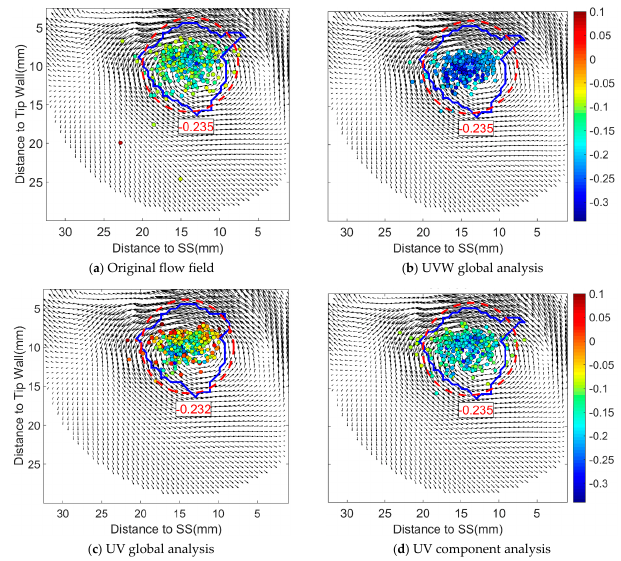
( c ) UV component analysis Figure 23. Statistics of instantaneous reconstructed flow field using first 10 modes at L/c = 1.1. To further validate the conclusions drawn above, we checked the reconstruction results using different number of modes and different retained energy portions of the original flow field. The standard deviation of the TLV radius and displacement are chosen to quantitatively analysis the difference between the two reconstruction criteria. The results in Figure 24 confirm that reconstructions using the same modes number can obtain nearly the same vortex distribution characteristics while reconstructions relying on the same energy fraction would lead to totally different vortex distribution characteristics.